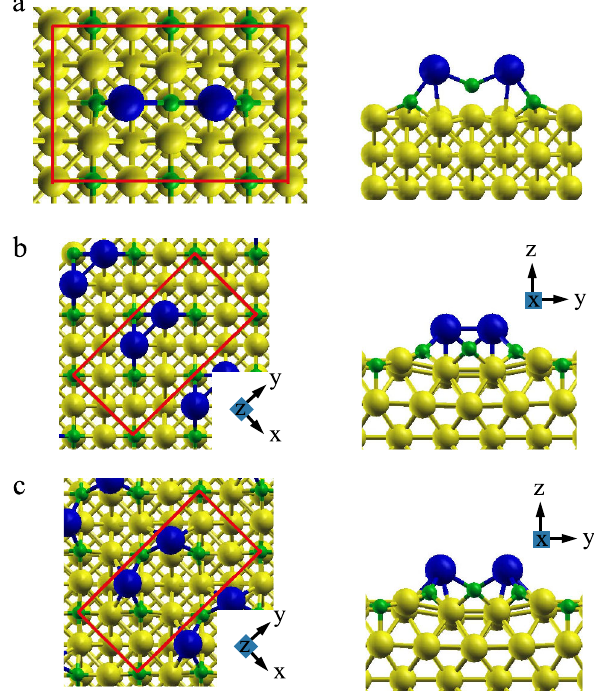
FIG. 2. (a) The top view and along-dimer side view of the relaxed linear Gd dimer on the CuN surface. (b),(c) Structural views similar to (a) for the initial (b) and relaxed diagonal (c) Gd dimers. All in-plane unit cells are marked by red rectangles. In all figures: blue, green, and yellow balls denote Gd, N, and Cu atoms, respectively.